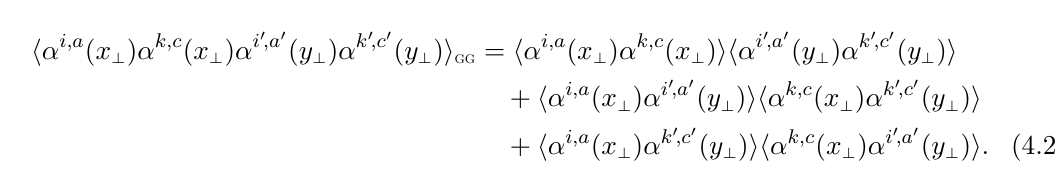
Figure 2. Left: comparison of the covariance of the divergence of the Chern-Simons current (lower pair of curves) and the energy density (upper pair of curves) against rQ s for Q s the exact analytical approach (blue full curves) and the Glasma Graph approximation (red dashed curves). Right: ratio of exact analytical result to the Glasma Graph result for the covariance of the divergence of the Chern-Simons current (blue full curve) and the energy density (red dashed curve). factorize into products of two-point correlation functions such